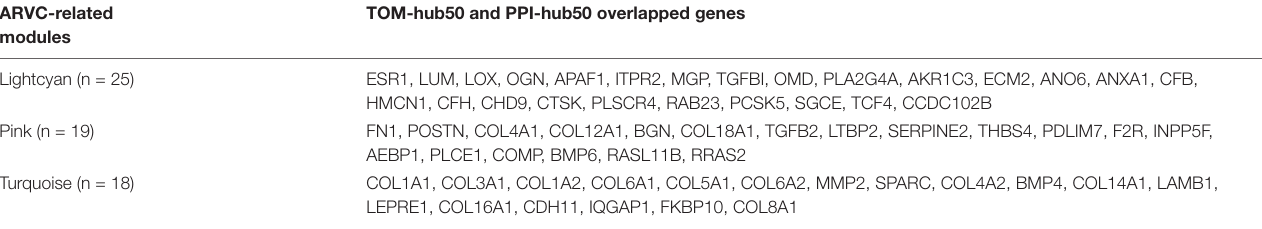
TABLE 1 | TOM-hub50 & PPI-hub50 overlapped genes in three ARVC hub modules. ARVC-related modules